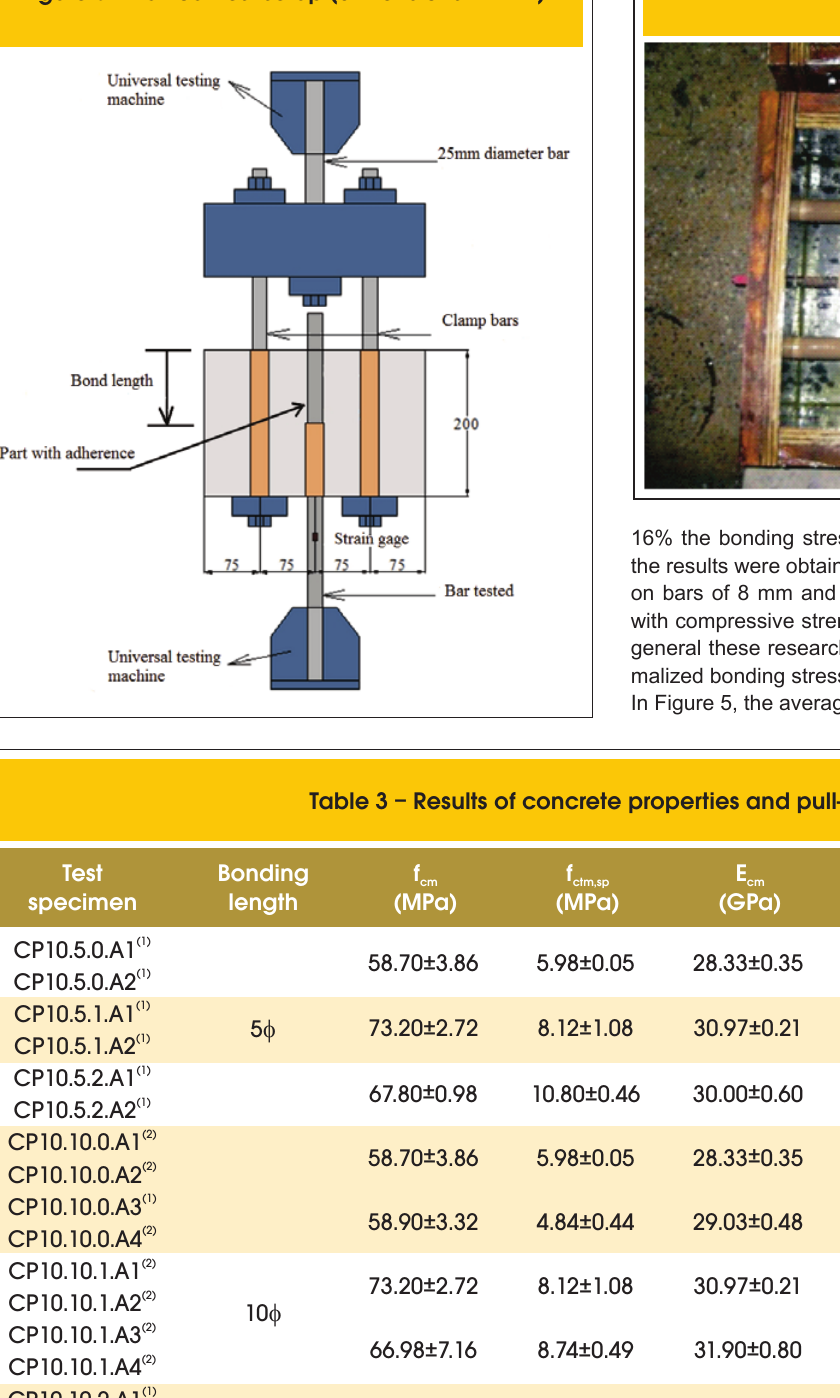
Figure 3 – Pull-out test setup (dimensions in mm)